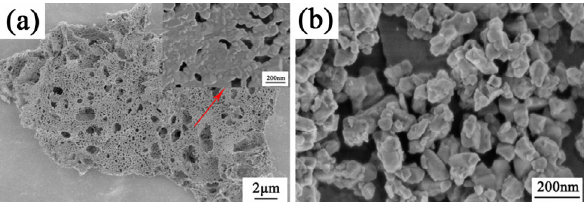
Fig. 3 Typical SEM images of powders synthesized by combustion method: (a) the as-burnt LaGdZr 2 O 7 powders calcined at 800 ℃ ; (b) LaGdZr 2 O 7 powders ball-milled for 20 h. Reproduced with permission from Ref. [47], © Elsevier Ltd.